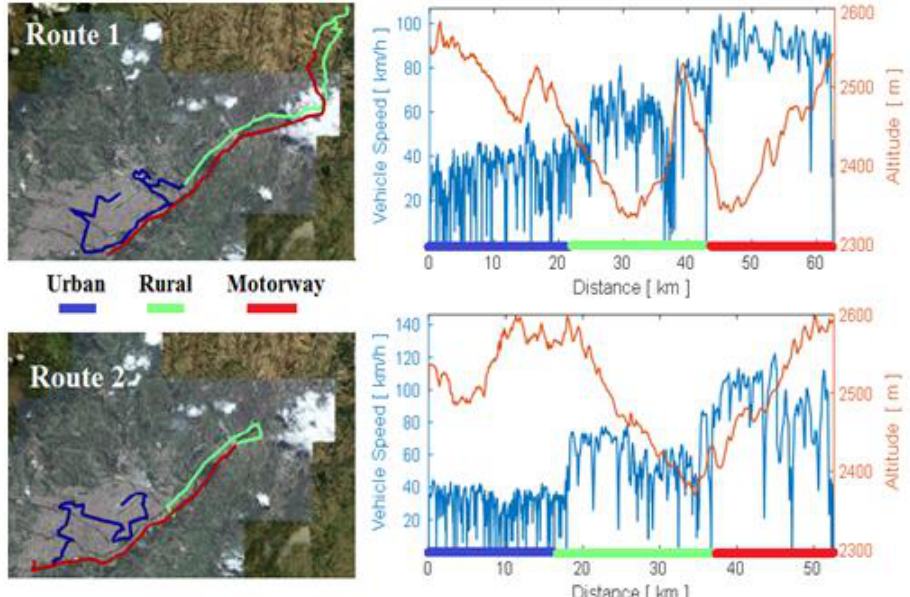
Figure 3. Route, altitude and speed during the RDE test.